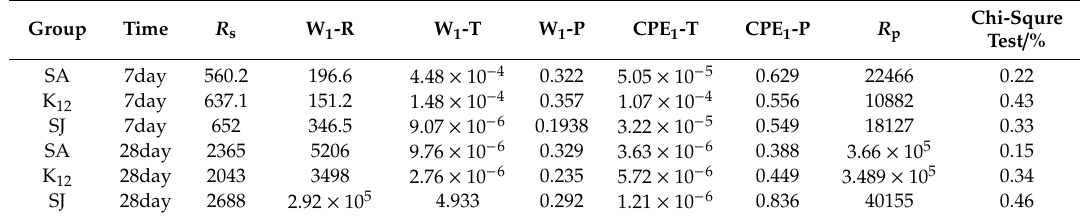
Table 5. Equivalent circuit model